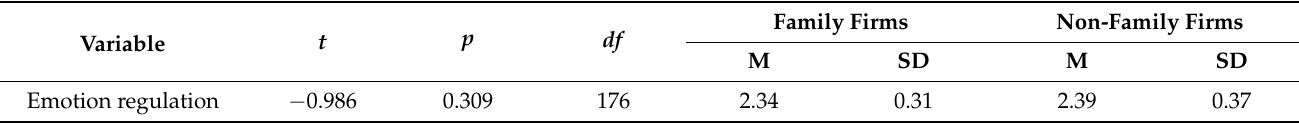
Table 3. t -Test: emotion regulation levels in family and non-family